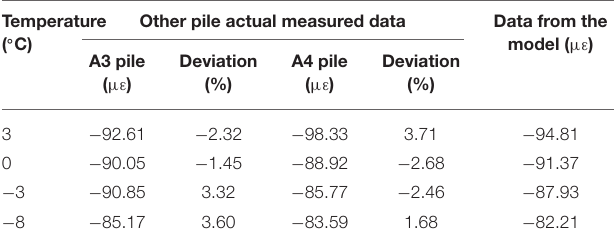
TABLE 9 | Temperature and strain model. TABLE 10 | Verify the temperature and strain model of section A.